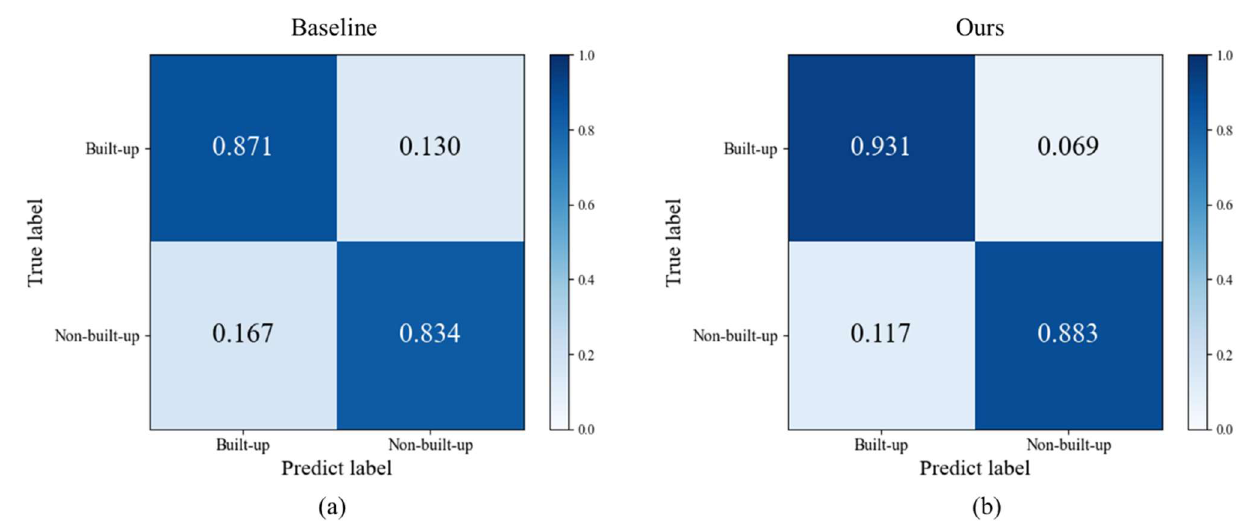
Figure 5. The CMs for different methods. ( a ) Baseline CM. ( b ) Our CM.